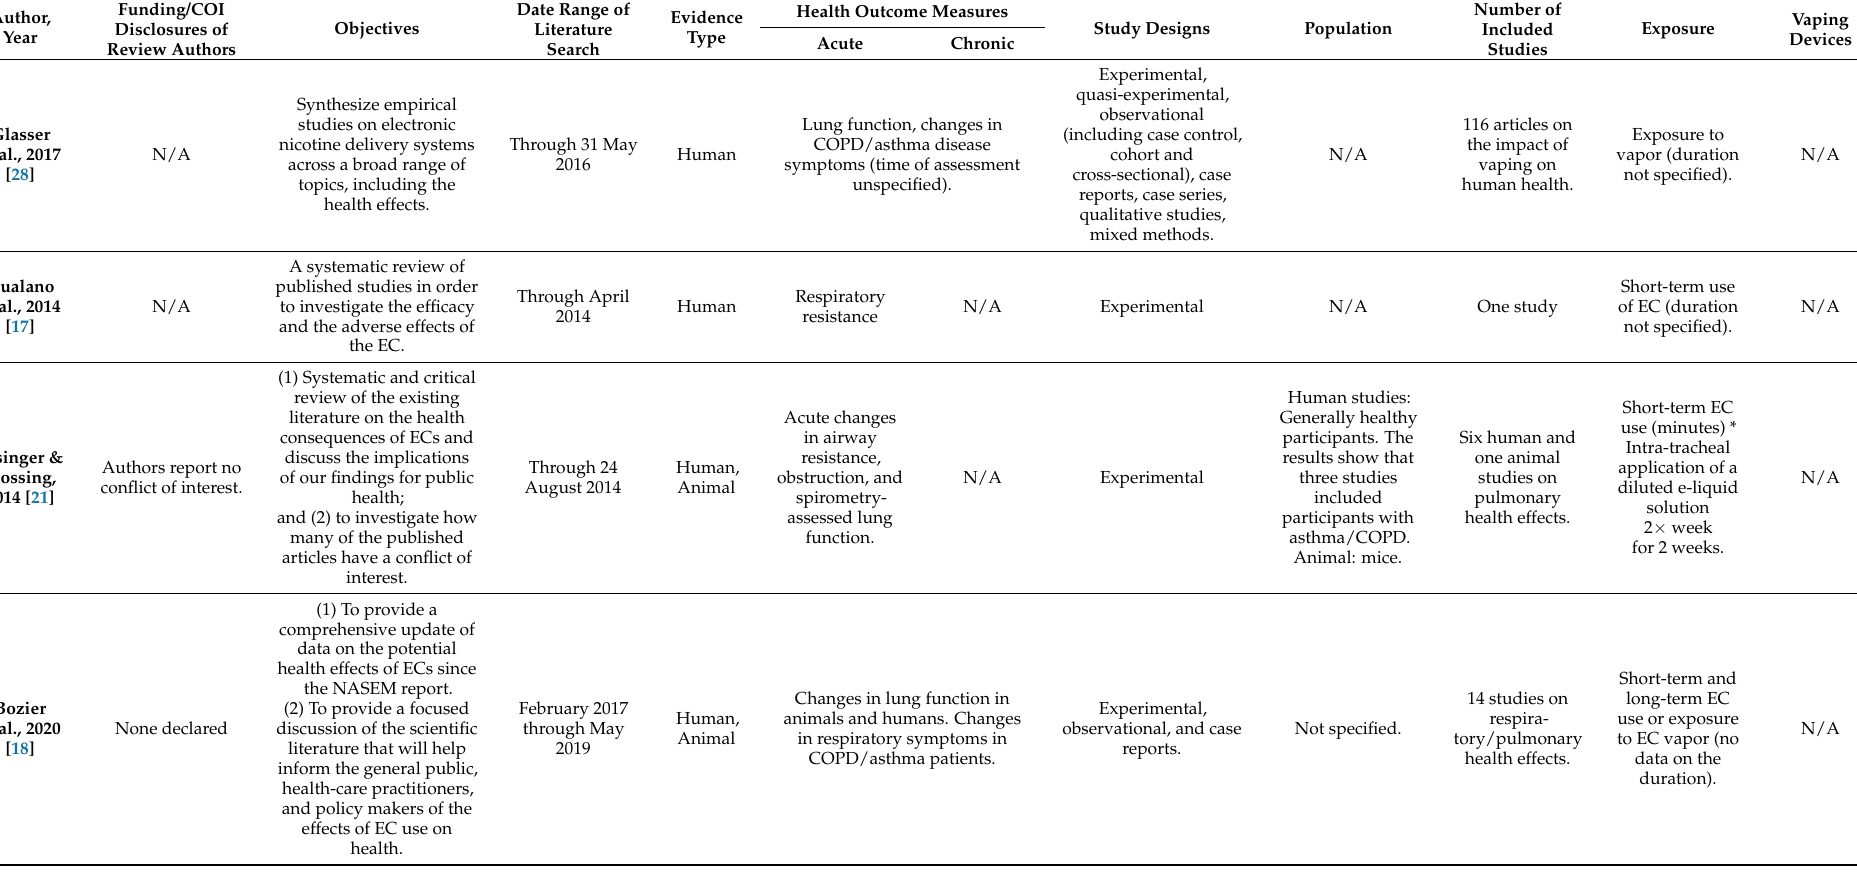
Table 2. Characteristics of systematic reviews on respiratory/pulmonary health risks of